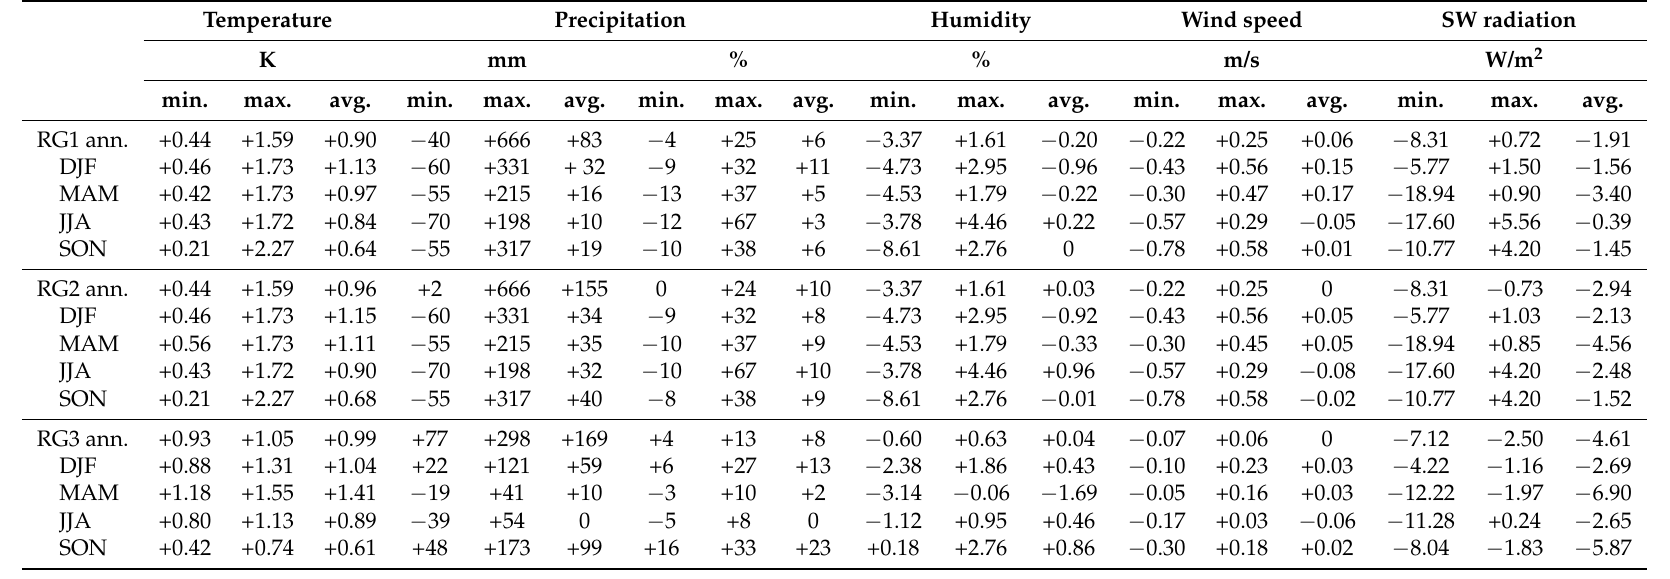
Table 3. Areal minimum, maximum, and average differences between scenario and control run for the variables temperature, precipitation, humidity, wind speed, and short-wave radiation in the three investigated regions RG1, RG2, and